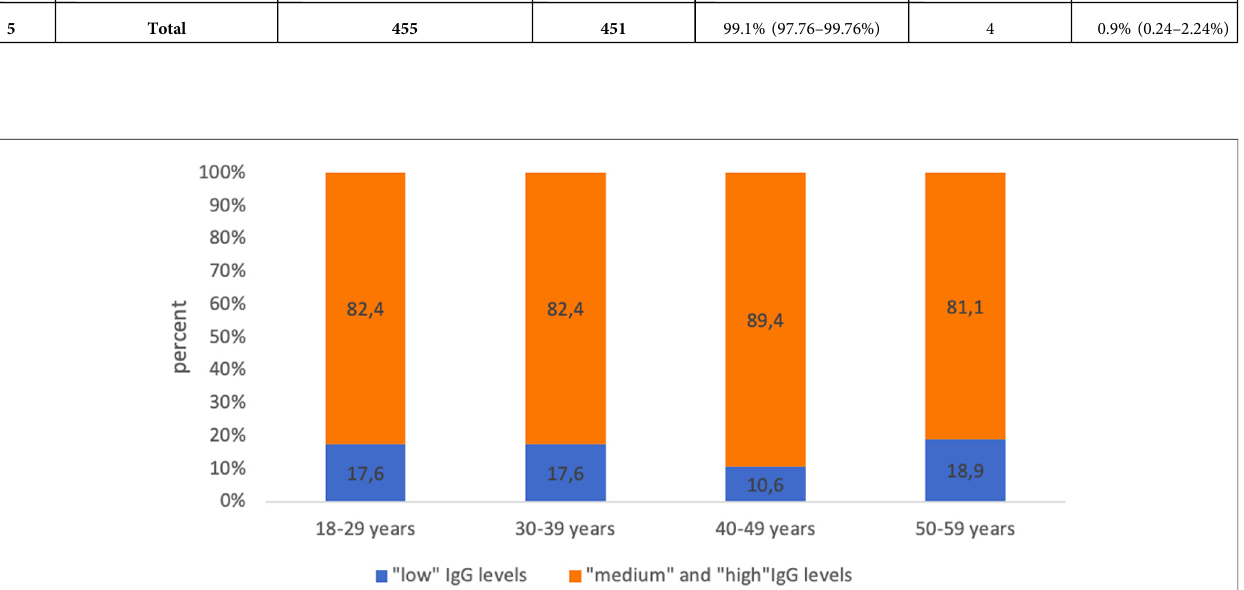
FIGURE 2 Proportion of seropositive healthcare professionals with “ low ” anti-diphtheria IgG levels and with “ medium ” and “ high ” anti-diphtheria IgG levels in different age groups.